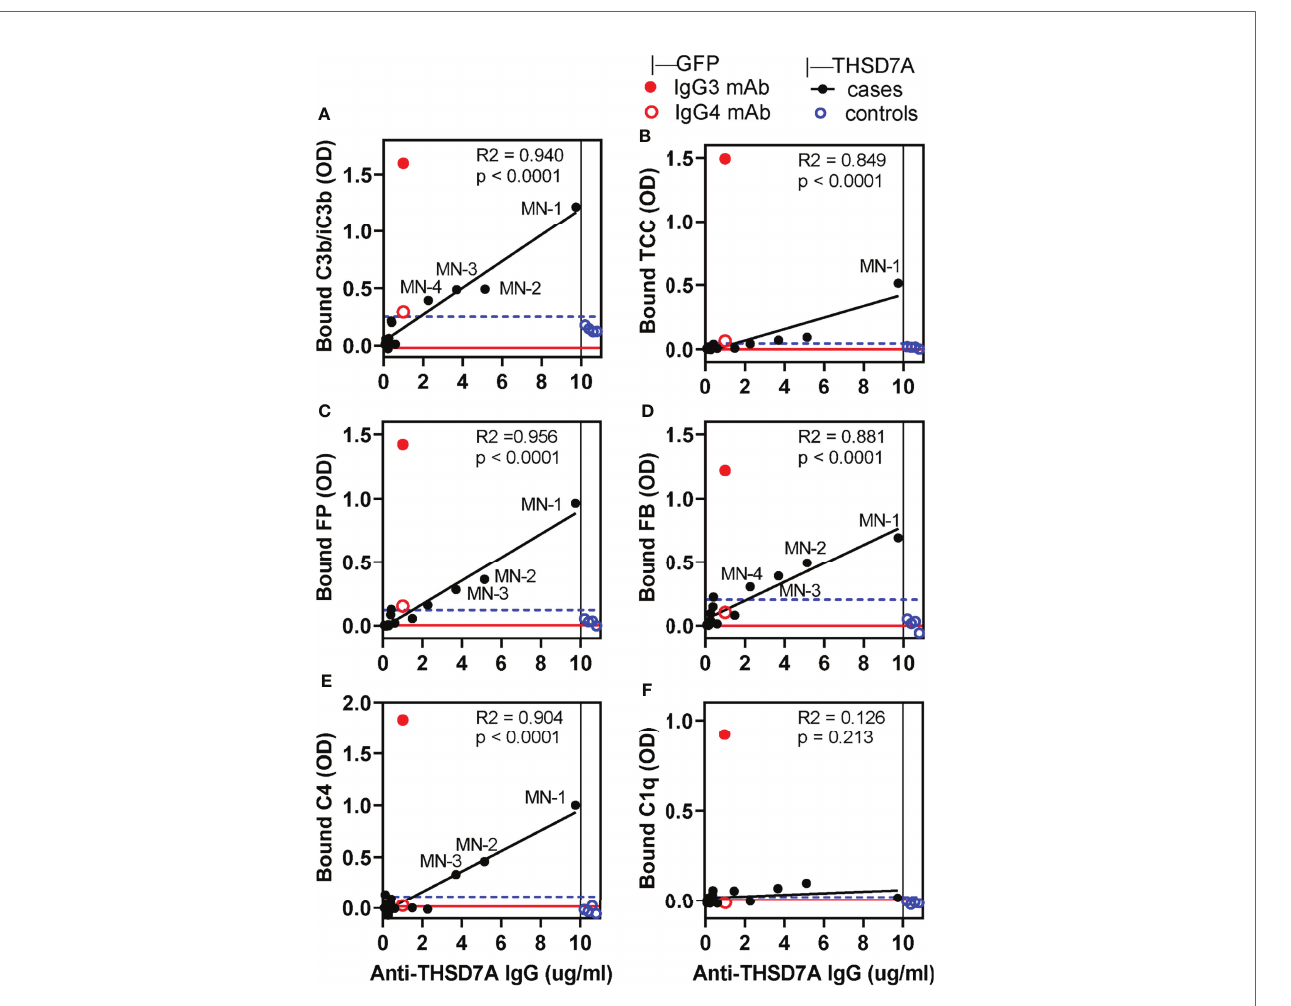
FIGURE 4 | In vitro complement activation by THSD7A ICs under conditions in which all activation pathways are active. Complement activation was performed using 10% normal human serum (NHS) diluted in GVB++ buffer containing Ca 2+ and Mg 2+ in wells coated with THSD7A (200 ng/well) and then incubated with sera MN-1 through MN-14 (solid black circles) or control sera (open blue circles), all diluted 1/25. For each sample, the x-coordinate indicates the concentration of anti-THSD7A IgG in the diluted MN serum. In parallel experiments, activation was performed on reference ICs prepared by incubating human IgG3 (1 m g/ml, solid red circle) and IgG4 (1 m g/ml, open red circle) anti-GFP mAbs in GFP-coated wells (200 ng/well). Graphs depict the binding of antibodies speci fi c to C3b/iC3b (A) , C5b-9/TCC (B) , FP (C) , FB (D) , C4 (E) , and C1q (F) . A blank correction was performed by subtracting the OD value on immobilized antigen incubated with PBS from the OD value of immobilized antigen incubated with antibody. The threshold for positivity (blue dashed line) was calculated as the mean OD of the control sera + 4 SD. Labels indicate MN sera which showed complement deposition above the positivity threshold. The OD values for MN sera were fi tted to the concentration of anti-THSD7A IgG in each sample (values taken from Figure 1 and divided by the dilution factor) by simple linear regression (black line). The red line indicates the baseline obtained by performing the complement activation assays using 10% heat-inactivated NHS in GVB++ as a source of